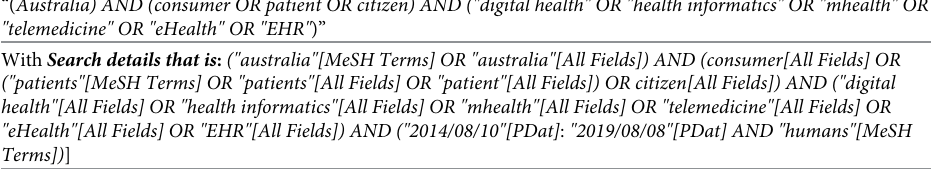
Table 2. Search syntax for literature